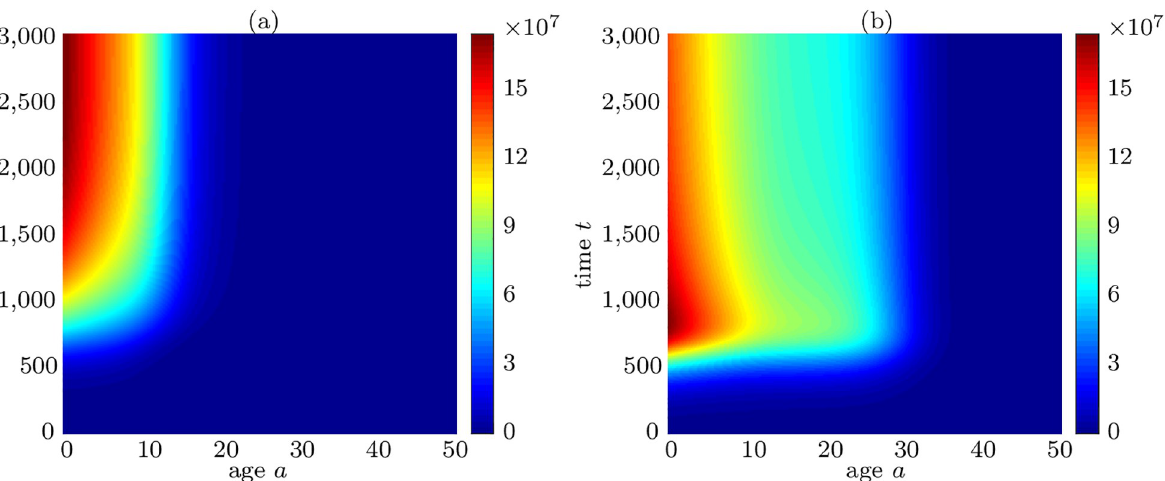
PLOS ONE | https://doi.org/10.1371/journal.pone.0280621 January 20,